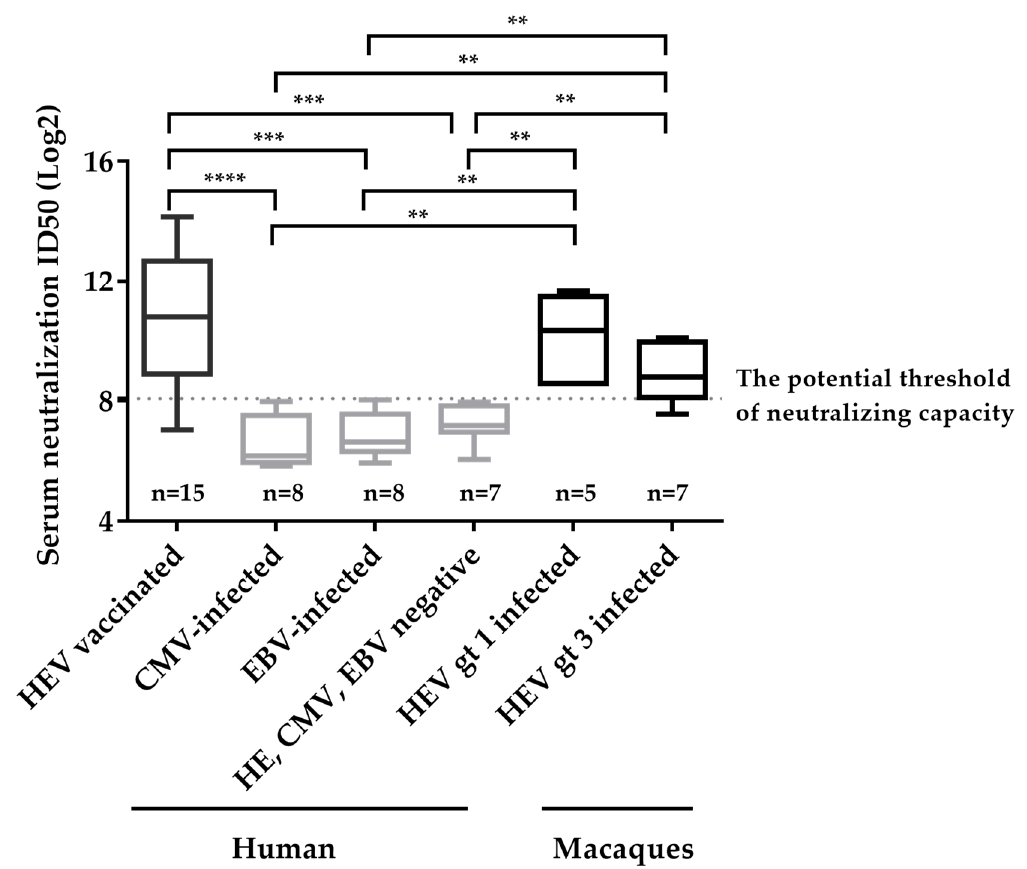
Figure 4. Determination of the potential threshold for neutralizing capacity and specificity of the neutralizing assay involving detection of secreted pORF2. Sera collected from 8 non-HEV, 8 CMV-infected individuals, 8 EBV-infected individuals and 15 HEV vaccinated donors, and 5 sera collected from HEV gt 1 infected macaques and 7 sera collected from HEV gt 3 infected macaques were included to analyze the specificity of the assay. The non-HEV sera were defined as HEV RNA negative, anti-HEV antibodies negative and HEV antigen negative; The CMV-infected patients were defined as anti-CMV IgG positive and HEV markers negative; The EBV-infected patients were defined as anti-EBV IgG positive and HEV markers negative. The potential threshold was set at maximum of Youden index (8.07). The dotted line represents the threshold of the neutralizing capacity of sera. The detection results for each group are shown as the range (whiskers), interquartile range (boxes), and median (line within boxes). **, p < 0.01; ***, p < 0.001; ****, p < 0.0001.